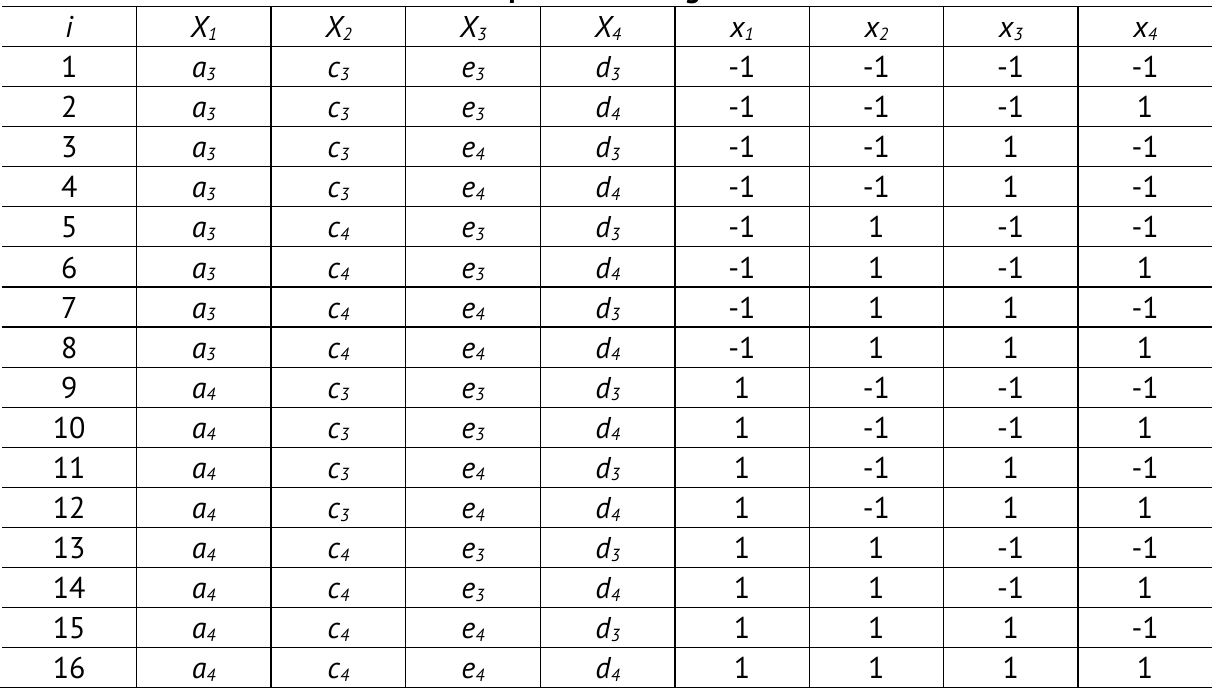
Experiment design